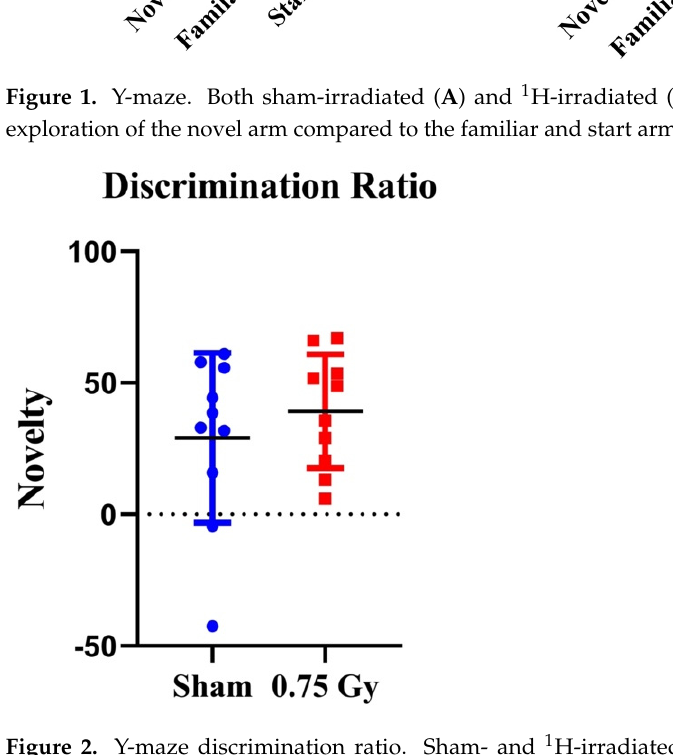
Figure 2. Y-maze discrimination ratio. Sham- and 1 H-irradiated animals displayed a positive discrimination ratio. There was no difference in discrimination ratios preferred to explore the novel arm.